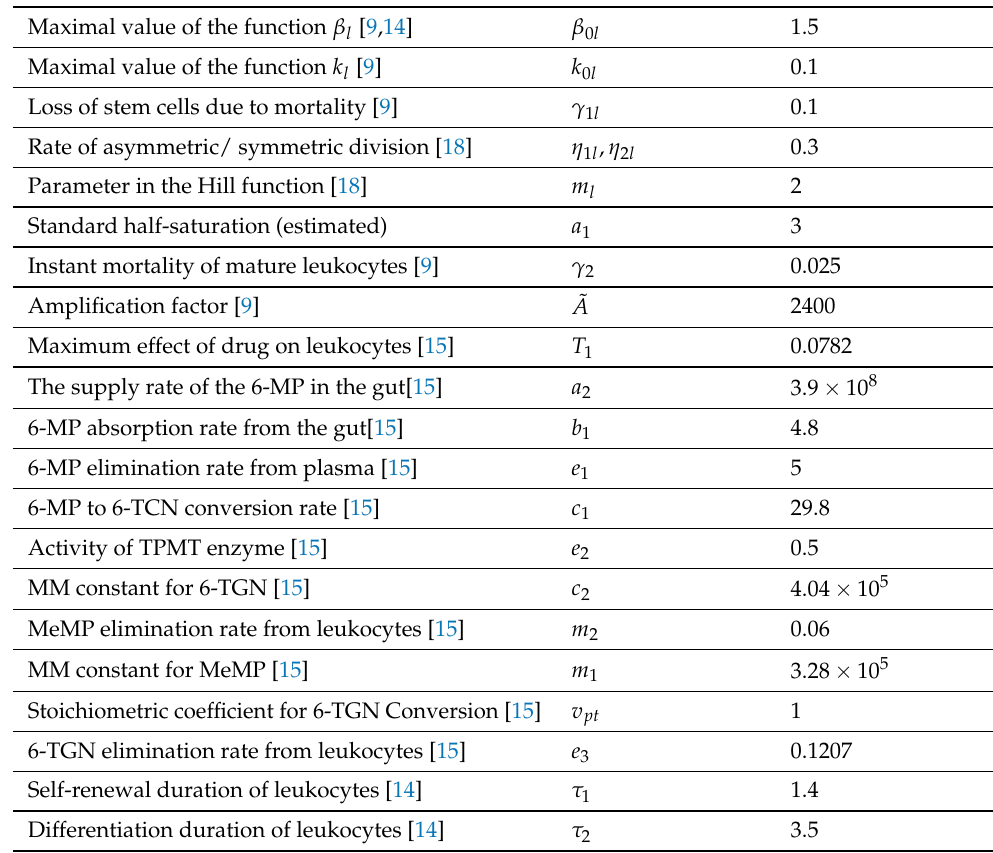
Table 2. Parameter values for the leukopoiesis